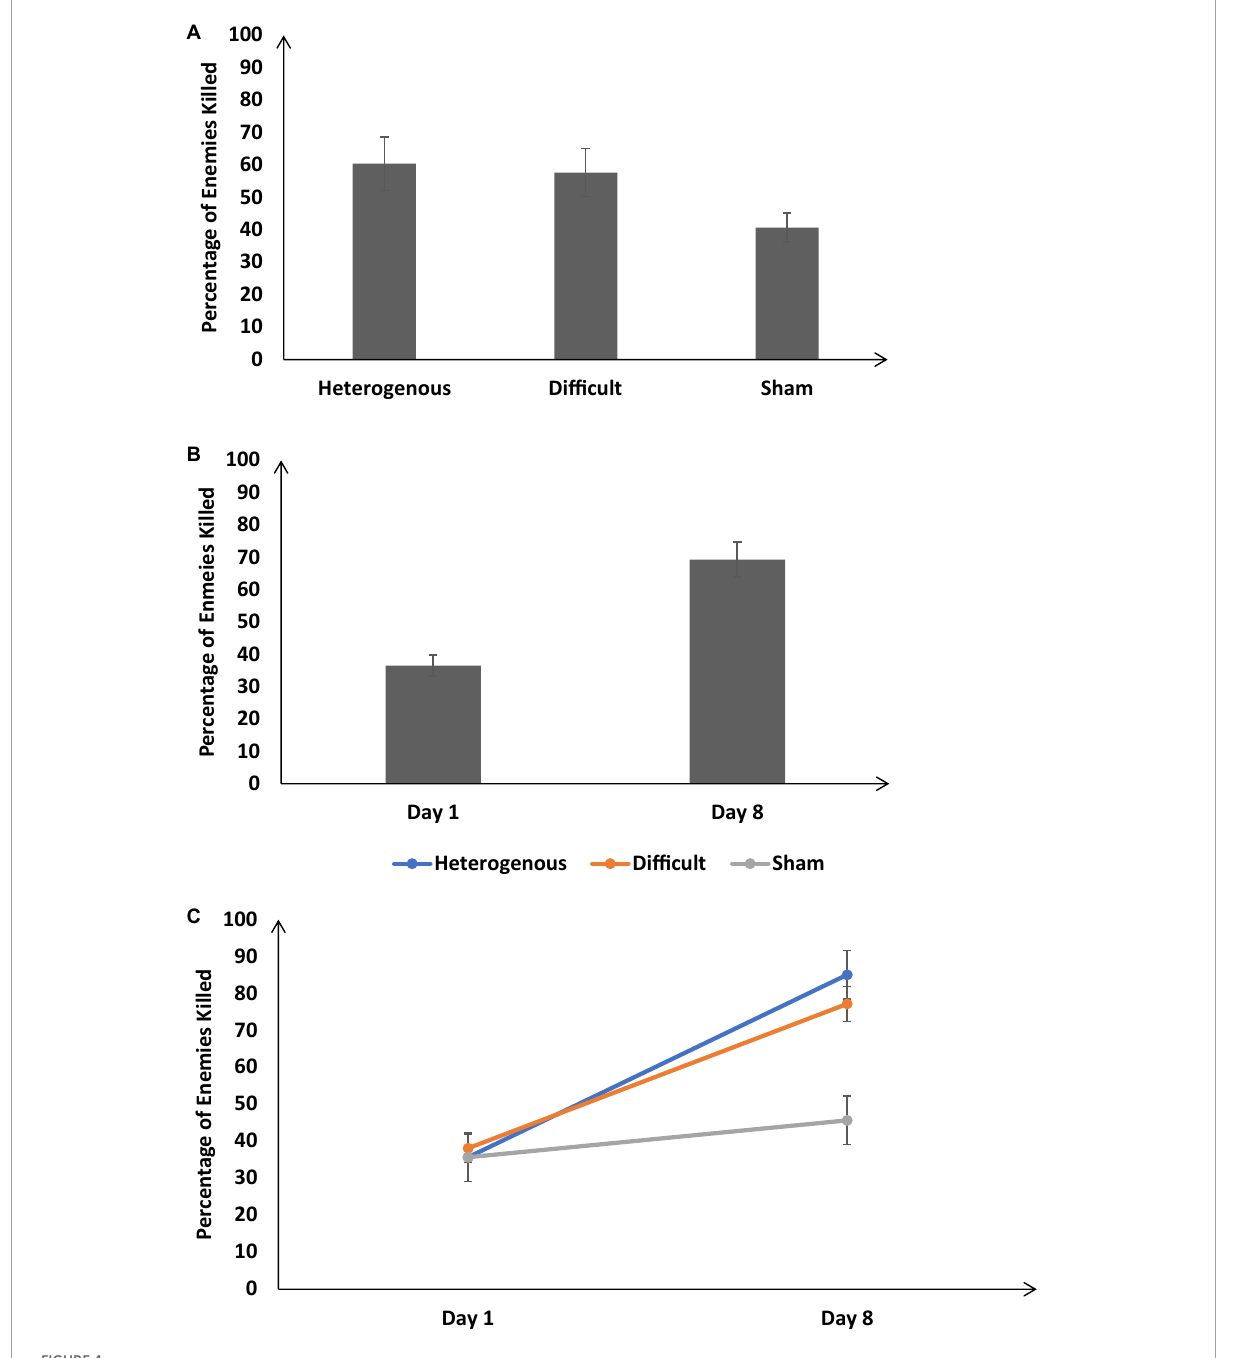
FIGURE4 (A) Percentage of enemies killed across different training conditions. (B) Percentage of enemies killed across Day 1 and Day 8. (C) Percentage of enemies killed across different training conditions and Day 1 and Day 8. The error bars show 95% CI around point estimates.